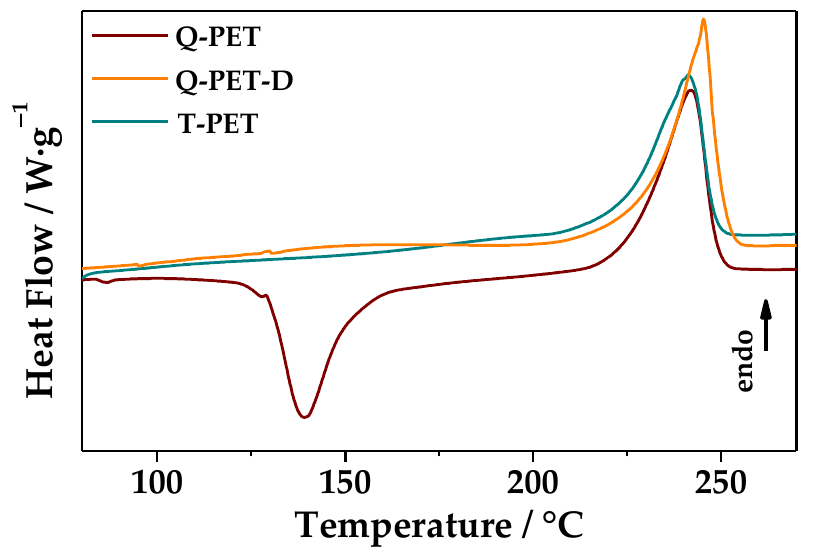
Figure 2. DSC traces corresponding to a heating cycle of the samples with different thermal treatments: T and Q processing conditions and Q-sample after the solvent immersion treatment (Q-PET-D).